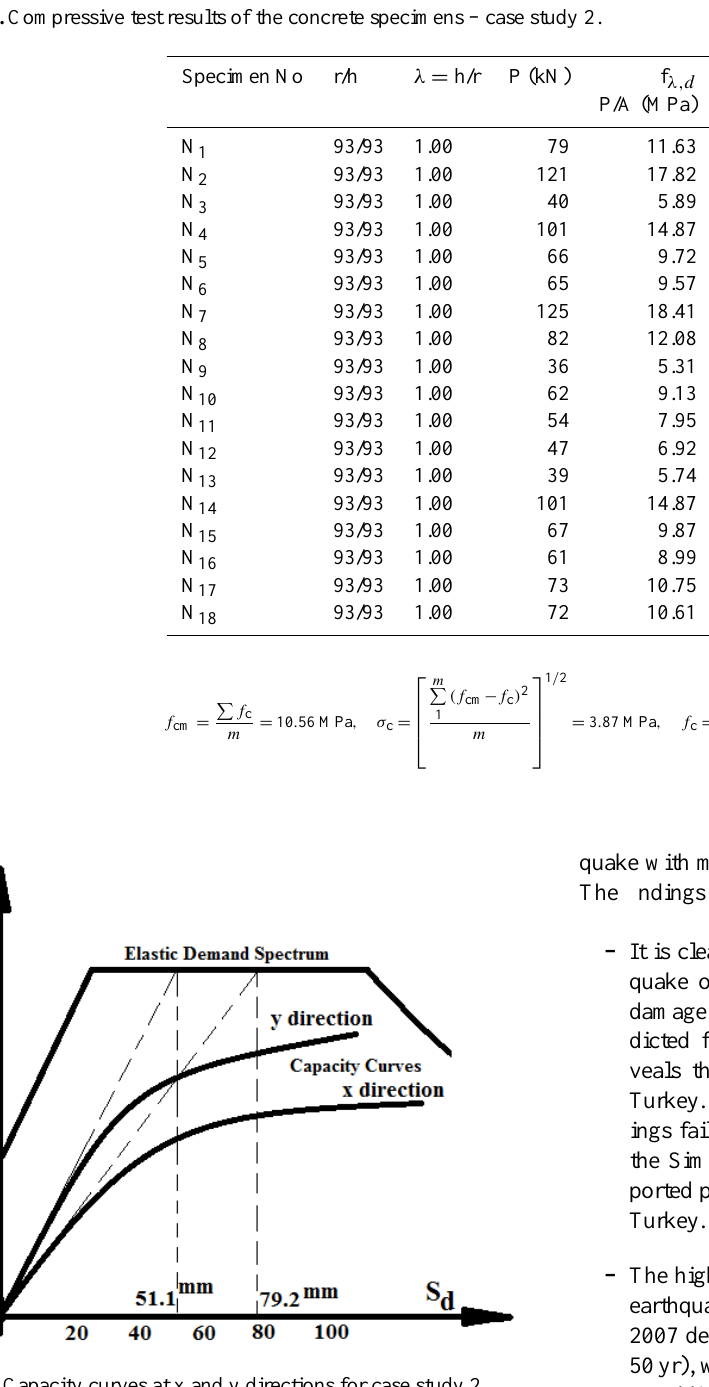
Fig. 21. Capacity curves at x and y directions for case study